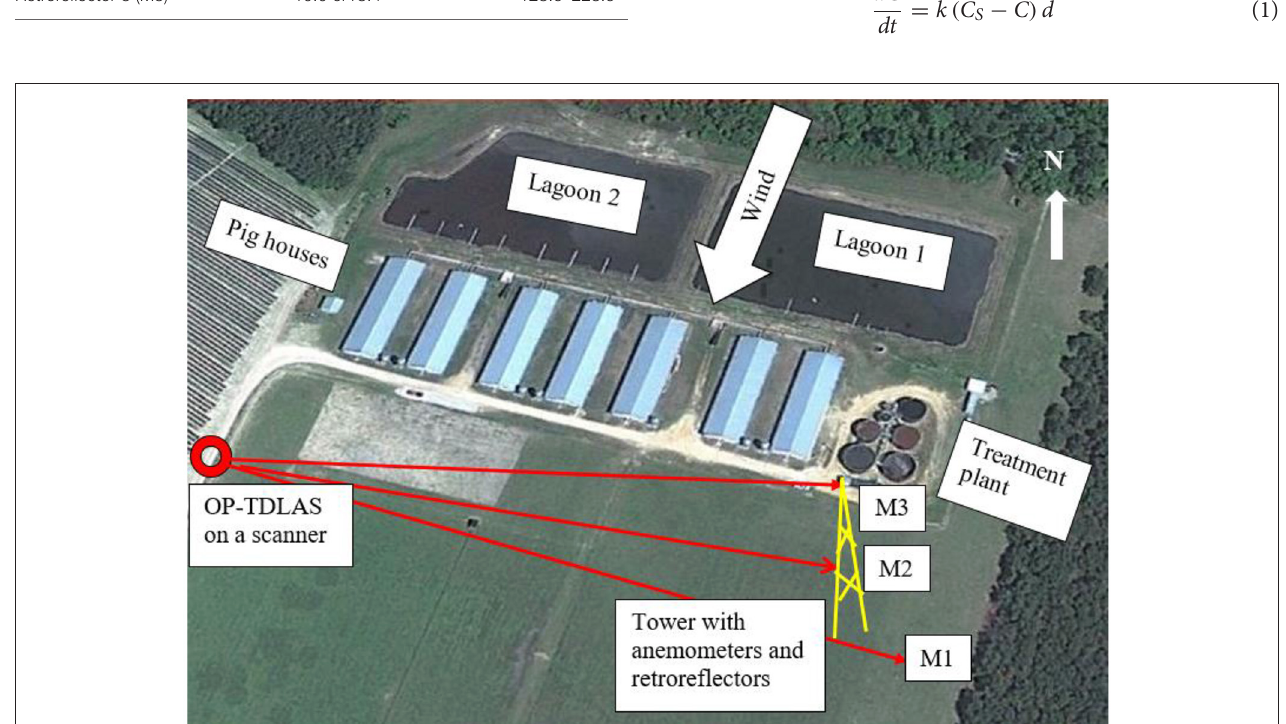
FIGURE 3 | VRPM beam geometry for NNE wind (M1, retroreflector 1m above ground; M2, retroreflector at 5–10m above ground; M3, retroreflector at 10–18.4m above ground).